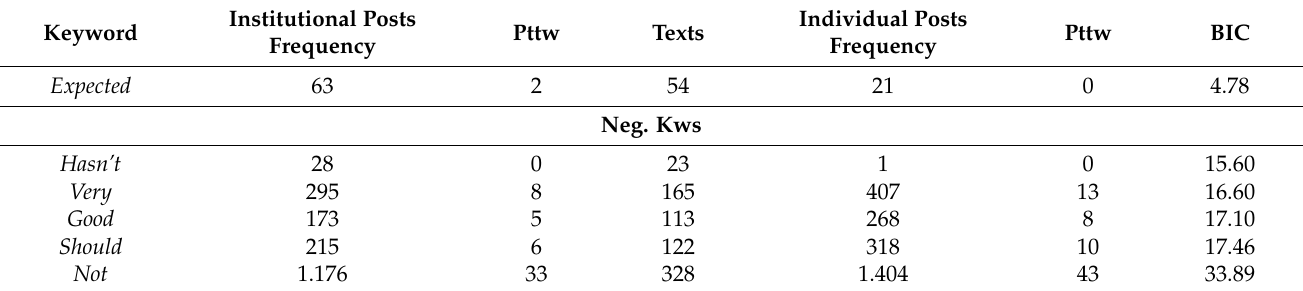
Table 8. Institutional vs. Individual blog posts: other elements of evaluative